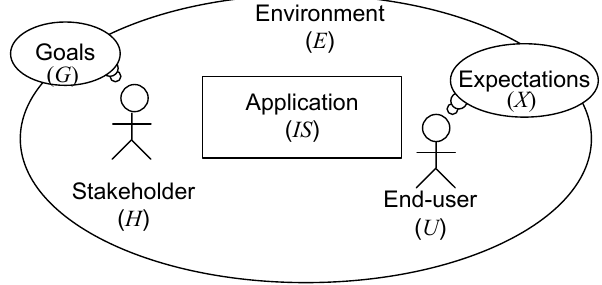
Figure 2. Stakeholder and End-user concepts in an adaptive